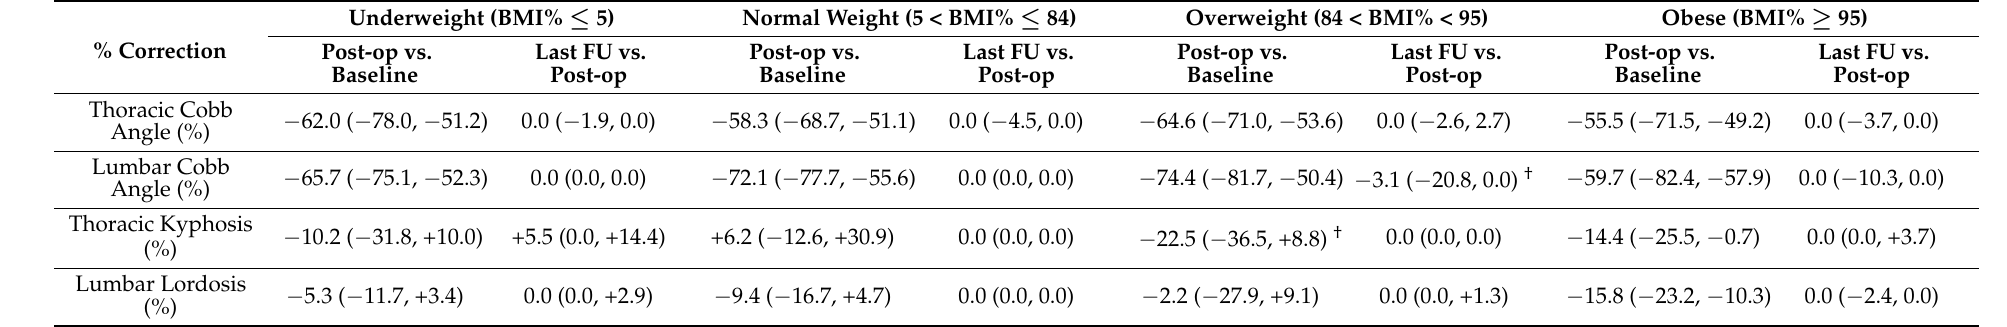
Table 5. Percentage change in correction angles expressed as median and interquartile range. † p < 0.05 vs. NW group. Statistical analysis: Kruskal–Wallis test with Dunn’s